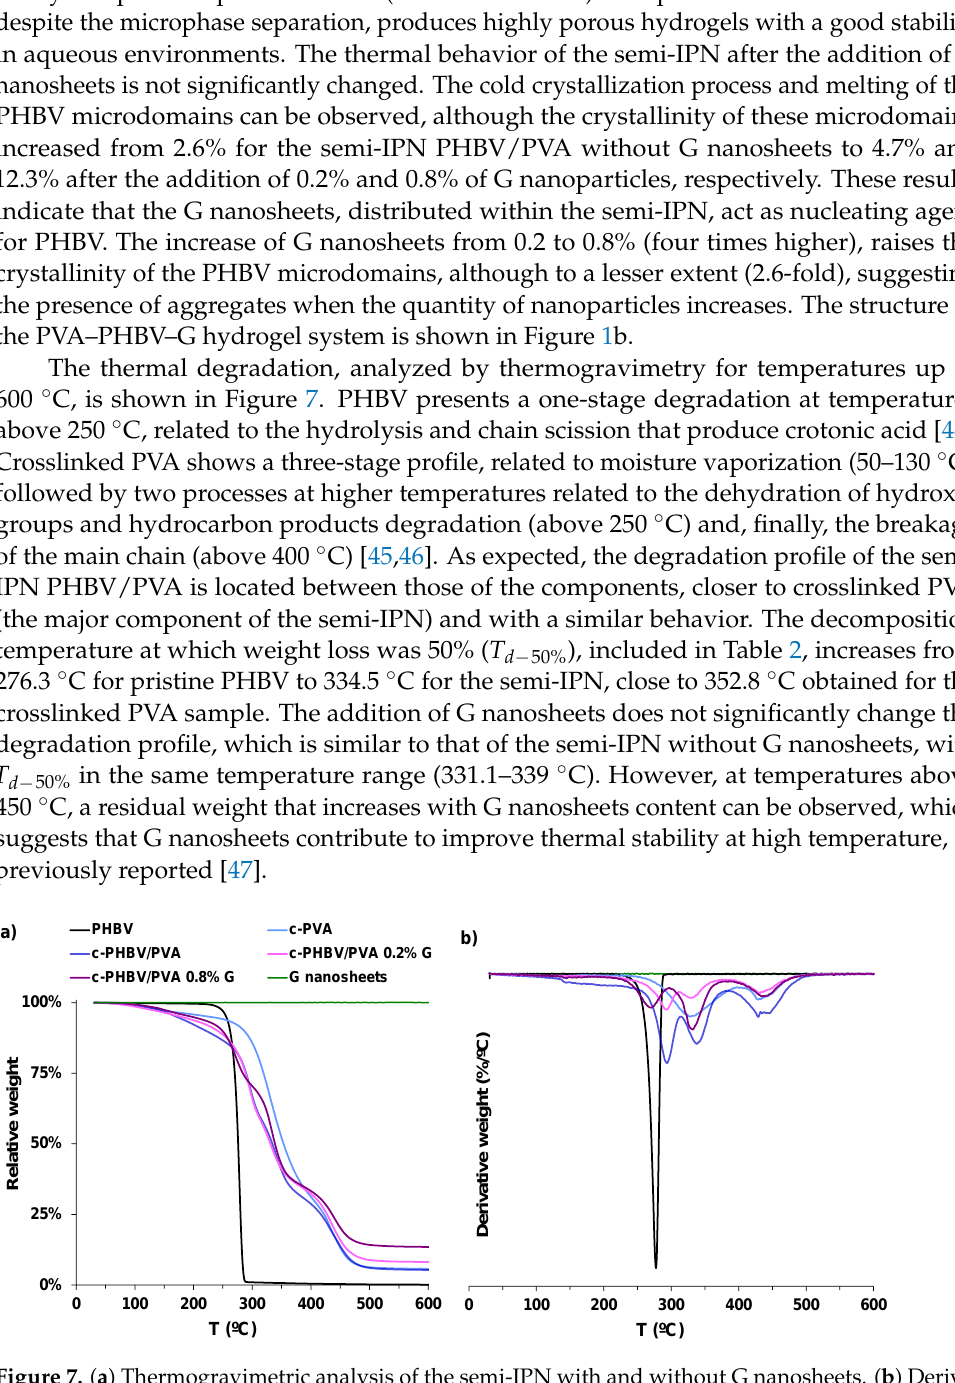
Figure 7. ( a ) Thermogravimetric analysis of the semi-IPN with and without G nanosheets. ( b ) Derivative of the weight loss. Neat PHBV and crosslinked PVA (c-PVA) are included as reference.